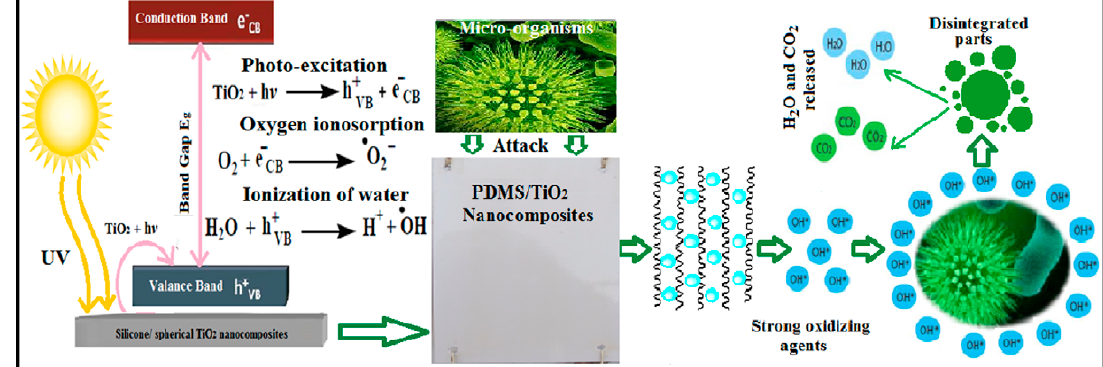
Figure 2. Scheme of fouling resistance mechanism under UV irradiation in PDMS-TiO 2 coating (permission of ref. [26], https://s100.copyright.com/AppDispatchServlet?publisherName=ELS&contentID=S2352340916305091&orderBeanRe- set=true).